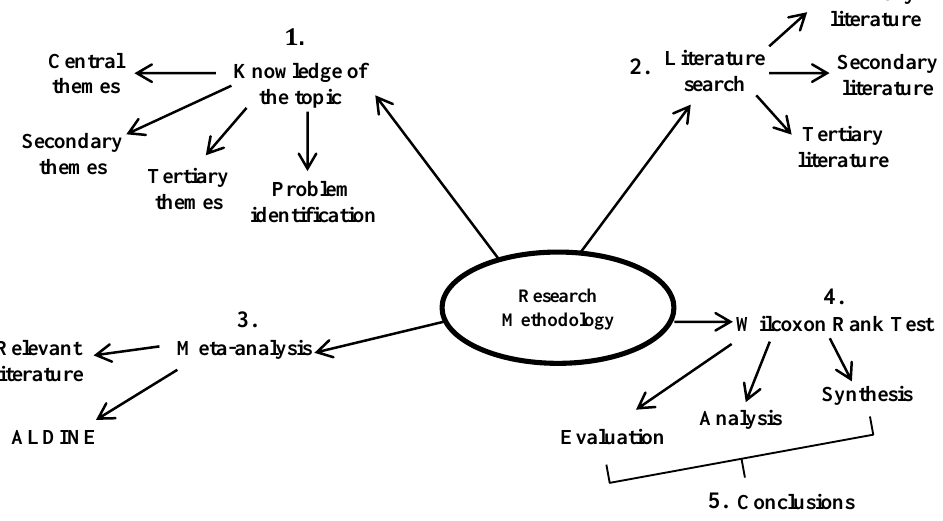
Figure 1. Flow chart of the research